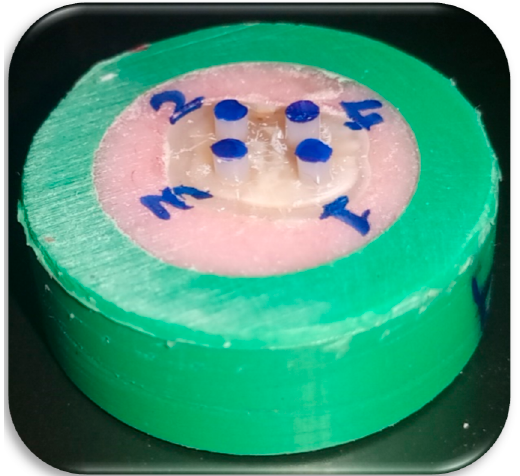
Figure 1. Four macroshear cylindrical composite samples bonded to dentinal